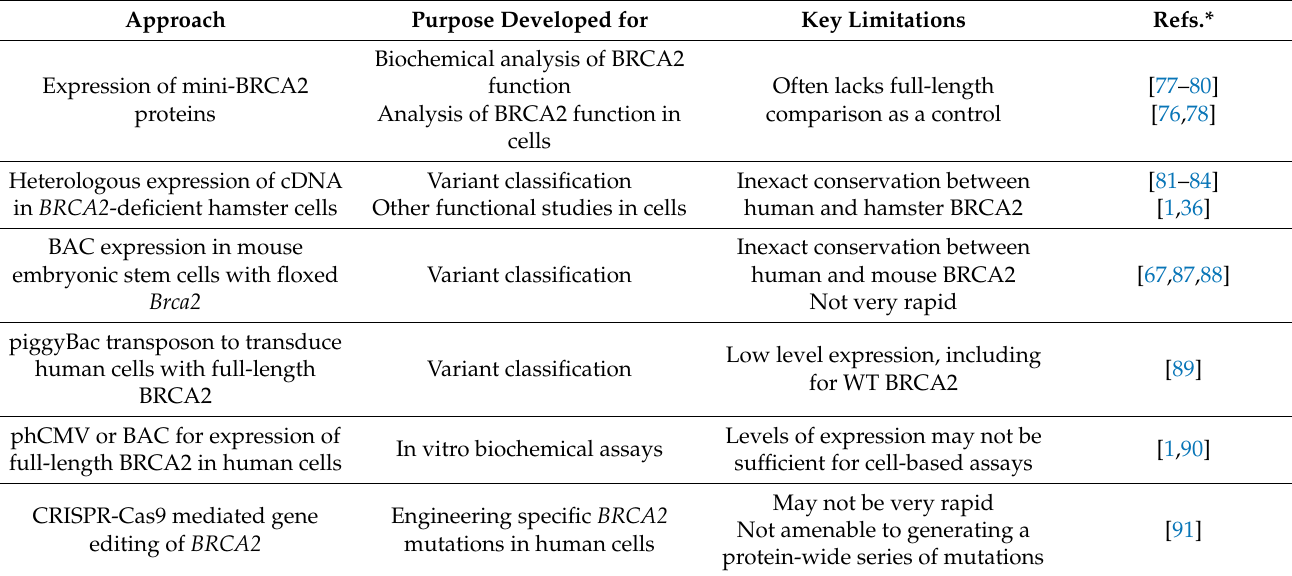
Table 1. Approaches for testing the functions of specific domains in BRCA2, the purpose they were originally developed for, and key limitations for testing specific domains.